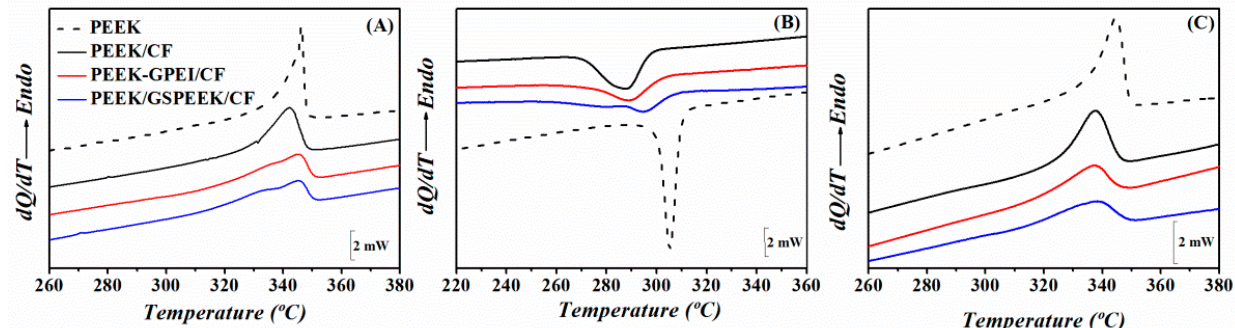
Figure 5. DSC scans of PEEK and the three laminates for ( A ) first heating, ( B ) first cooling, and ( C ) second heating. The colour code in ( A ) applies to all data.Regarding the crystallization behaviour, the crystallization temperature of all lami- nates decreases with respect to PEEK, indicating a reduction in the crystallization rate (Figure 5B). This behaviour was already observed in PEEK/graphene nanocomposites [31], and was attributed to the restriction of chain mobility due to the graphene network and was also a consequence of the interactions between the PEEK matrix and the amorphous com- patibilizers (GPEI or GSPEEK) [31].